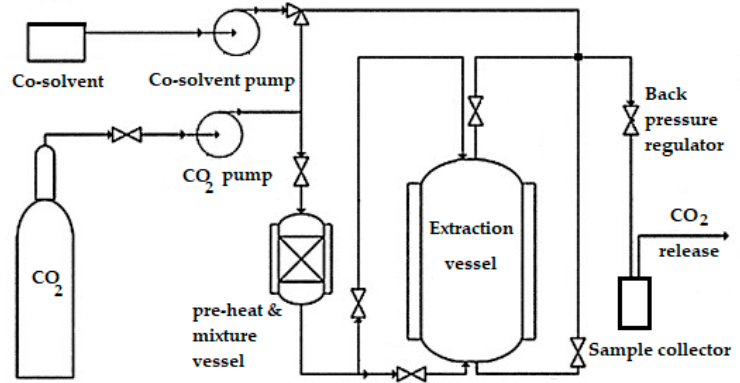
Figure 2. Scheme showing supercritical fluid extraction